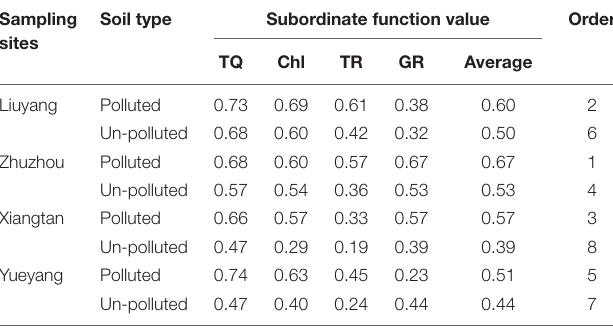
TABLE 5 | The subordinate function of cadmium tolerance of bermudagrass collected from different areas of Hunan province. Sampling sites